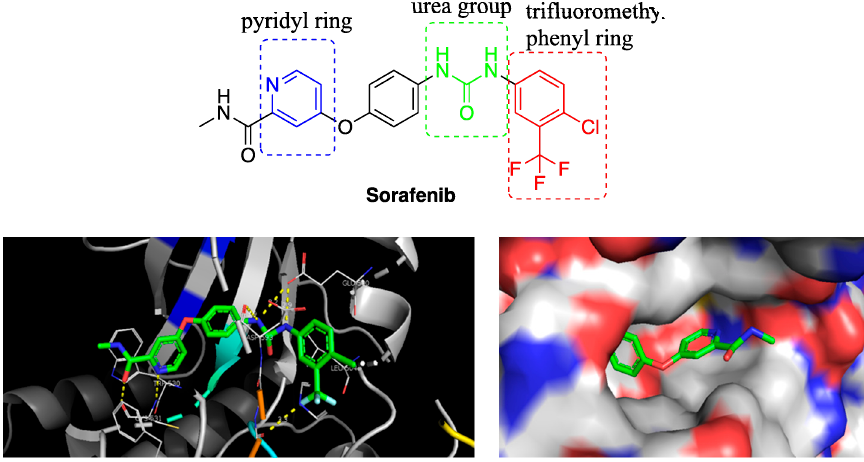
Figure 1. The structure of sorafenib (top) and the binding mode (bottom, left) and binding cavity (bottom, right) of sorafenib and B-RAF kinase.